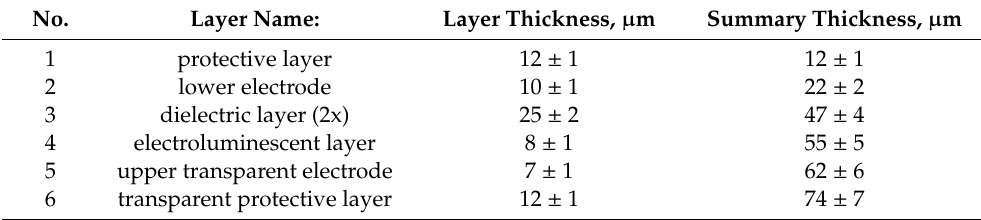
Table 1. Results of electroluminescent display thickness measurements.